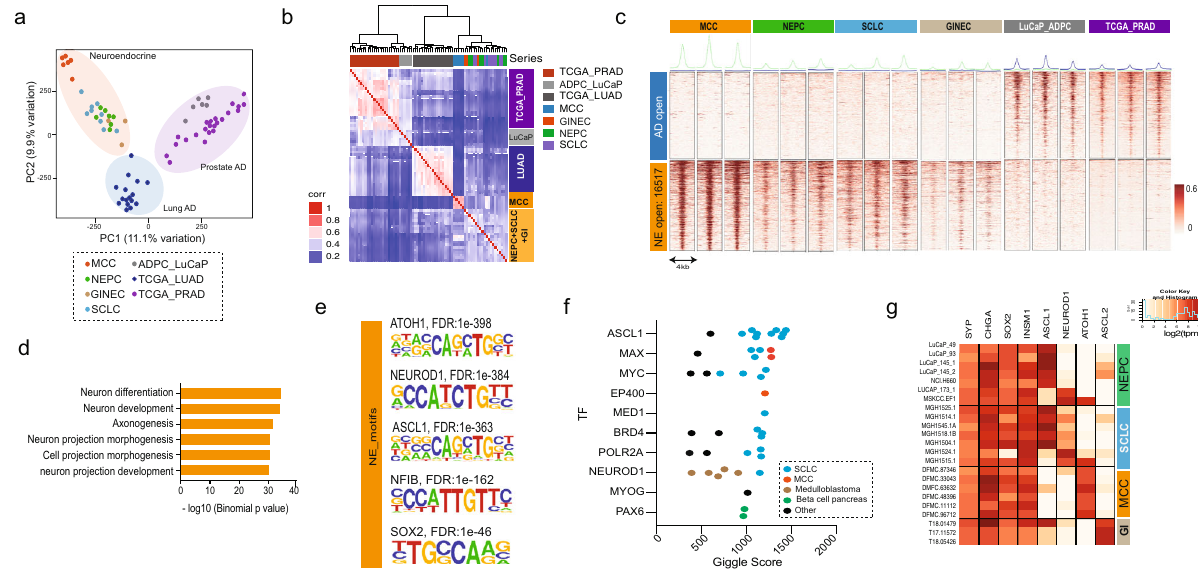
Fig. 1 NE carcinomas share a common chromatin state independent of their anatomical origin. a Principal component analysis (PCA) of ATAC-seq data of NECs including Merkel cell carcinoma (MCC), neuroendocrine prostate cancer (NEPC), gastrointestinal neuroendocrine carcinoma (GINE), and small- cell lung cancer (SCLC). The plot also includes prostate adenocarcinoma (PDX models and TCGA primary tissues) and lung adenocarcinoma (TCGA primary tissues). b Hierarchical clustering of the pairwise Pearson ’ s correlation of the ATAC-seq signal across the distinct tumor types. c Heatmap representation of the differential regions between representative ADs and NECs. Each row is a peak location and each column is a sample. Shown above each column are the composite tag density plots for the AD sites (blue) and NE sites (green). d Gene Ontology enrichment using a binomial test 17 showing the pathways enriched in genes with nearby NE-speci fi c accessible regions shown in c . e Top results from motif analysis of the NE-speci fi c accessible regions. f Public ChIP-seq data sets showing the highest overlap with the NE-speci fi c accessible regions as determined by CistromeDB toolkit annotated by tissue type. The TFs are ordered by the top scoring data set of each type. g Expression of NE markers and bHLH TFs across all the NEC samples in our study displayed as a heatmap. Source data are provided as a Source Data fi